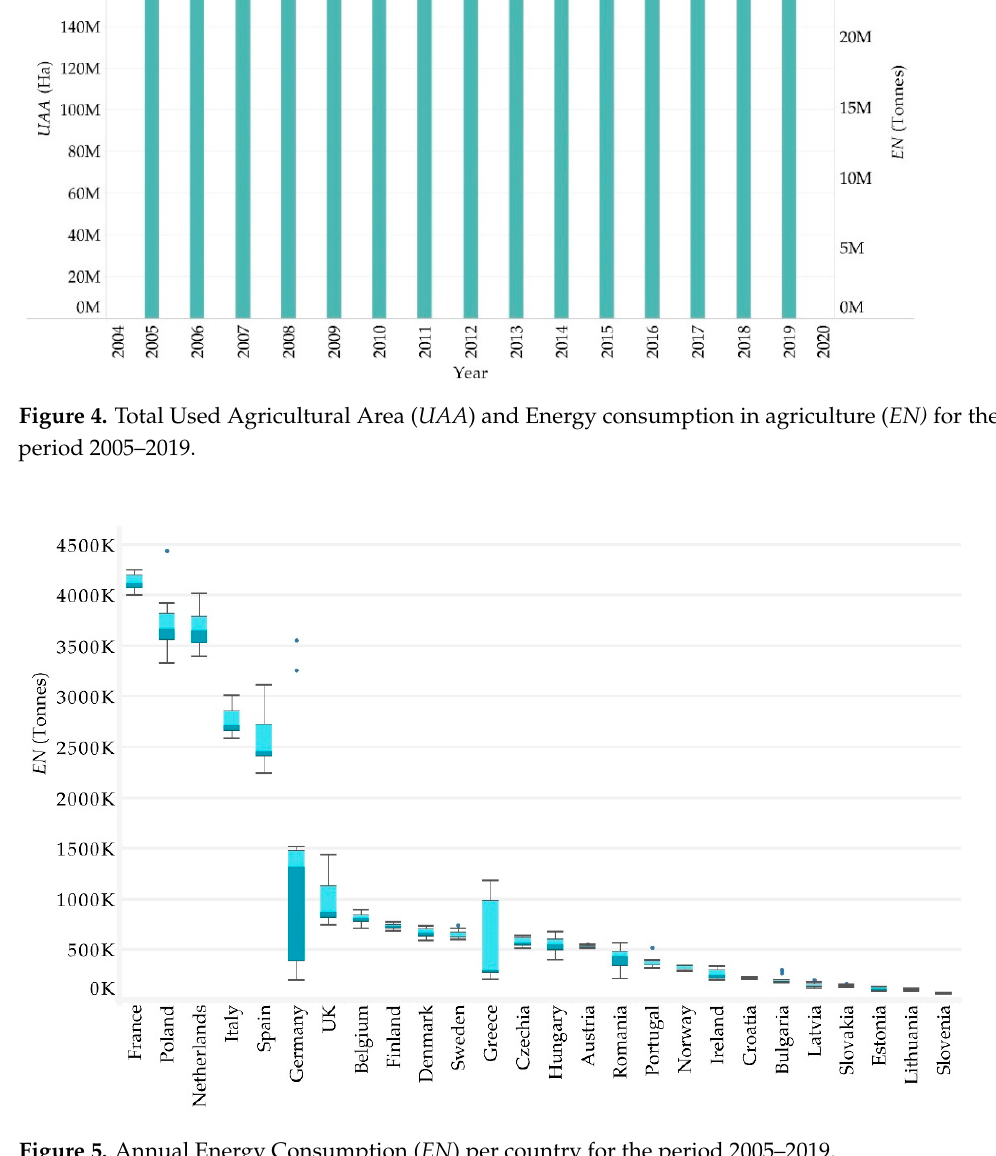
Figure 5. Annual Energy Consumption ( EN ) per country for the period 2005–2019.